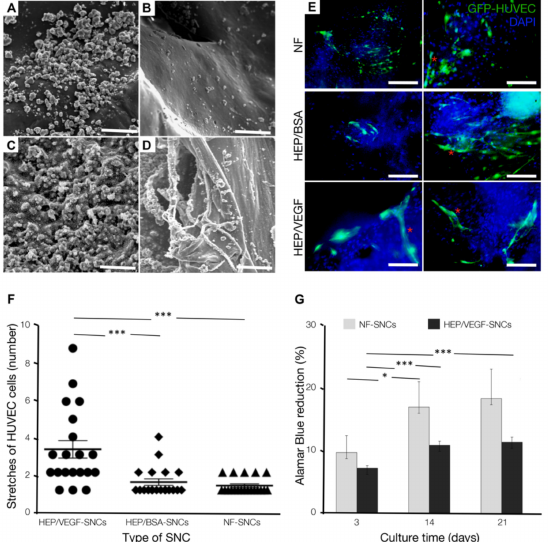
Figure 2. Nano-functionalization of the bone substitute with HEP/VEGF-SNCs and its effect on the organization of umbilical cord-derived endothelial cells in vitro. ( A – D ) SEM pictures of bone substitutes deposited with either - (NF-) ( A , B ) or HEP/VEGF- ( C , D ) SNCs. The SNCs were found on both the mineral ( A , C ) and the protein ( B , D ) constituents of the biphasic bone substitute. Scale bar in ( A , C ): 5 µ m; in ( B , D ): 10 µ m. ( E ) Fluorescence micrographs of GFP-HUVECs co-seeded with hMSCs on the bone substitute deposited with either NF-, HEP/BSA-, or HEP/VEGF-SNCs, after 21 days of culture. Nuclei counterstained with DAPI. Scale bars: 150 µ m. ( F ) Number of GFP-HUVECs found organized in vessel-like structures (red asterisk in ( E )) on NF-, HEP/BSA-, or HEP/VEGF-SNCs bone substitutes. Bars represent mean ± SEM ( n = 20 per condition); ***: p < 0.001. ( G ) The presence of reduced alamarBlue ® (indicating increased cell proliferation/cell metabolism) was quantified for the cells seeded on bone substitutes either deposited with NF- or HEP/VEGF-SNCs, after 3, 14, and 21 days of culture. Values expressed as mean ± SEM ( n = 4). *: p < 0.1; ***: p <